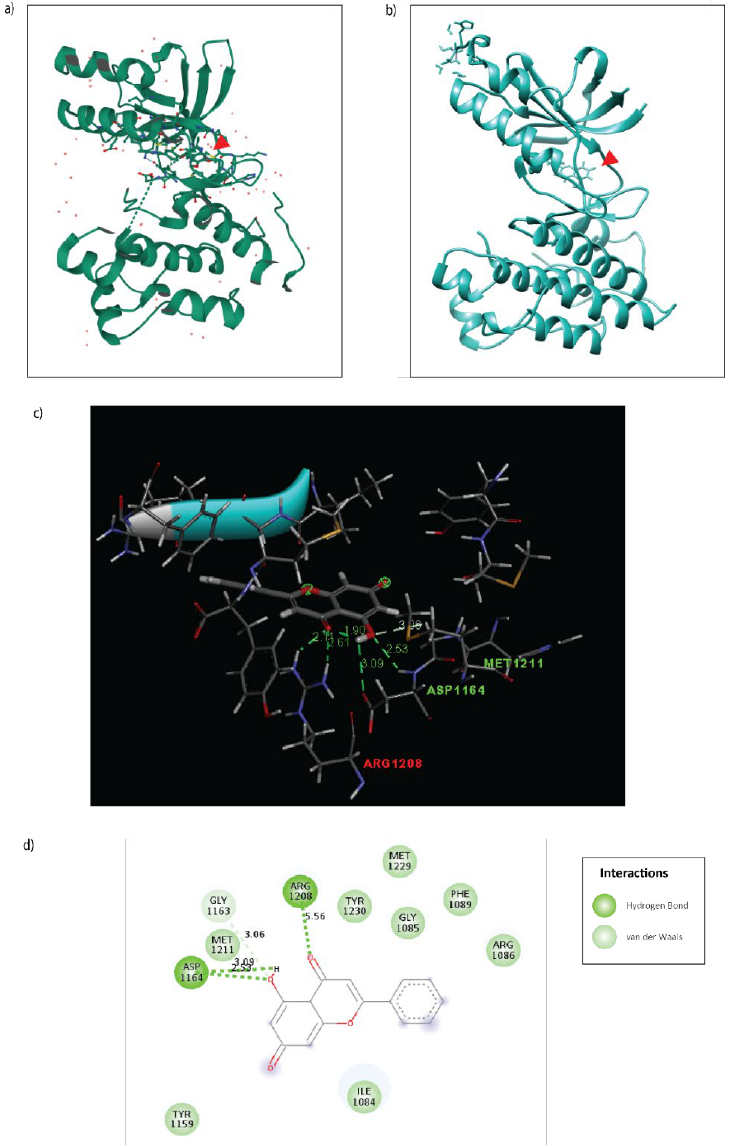
Figure 5. Molecular docking of Galangin to the tyrosine kinase domain of the c-Met receptor. ( a ) 3D X-ray crystallography structure of c-Met inhibitor, AM7, bound to c-Met (PDB: 2RFN). ( b ) 3D Docking model of Galangin (PDB: 57D docked to the c-Met receptor (PDB:1R1W) using SwissDock. ( c ) 3D interaction plot of Galangin binding to c-Met receptor with distance in (Å). ( d ) 2D interaction plot of Galangin binding to c-Met receptor. The important interactions were highlighted, including conventional hydrogen bond (dark green dot line) and van der Waals (light green).